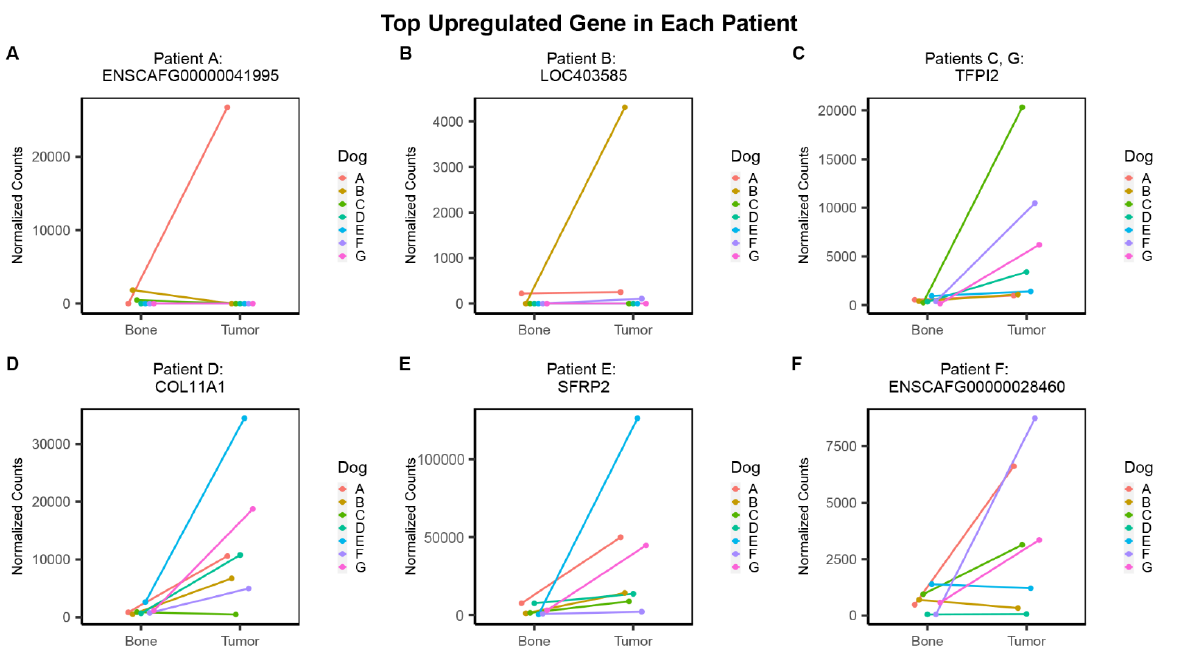
Figure 5. Plots of the top upregulated gene for each dog based on individual-level analysis reveal further variation among patients. The normalized counts of the top upregulated gene in each patient is shown. The top upregulated gene for patient A was ENSCAFG00000041995 ( A ). The top upregulated gene for patient B was LOC403585 ( B ). Patients C and G shared the same top upregulated gene, TFPI2 ( C ). The top upregulated gene for patient D was COL11A1 ( D ). The top upregulated gene for patient E was SFRP2 ( E ). The top upregulated gene for patient F was ENSCAFG00000028460 ( F ).